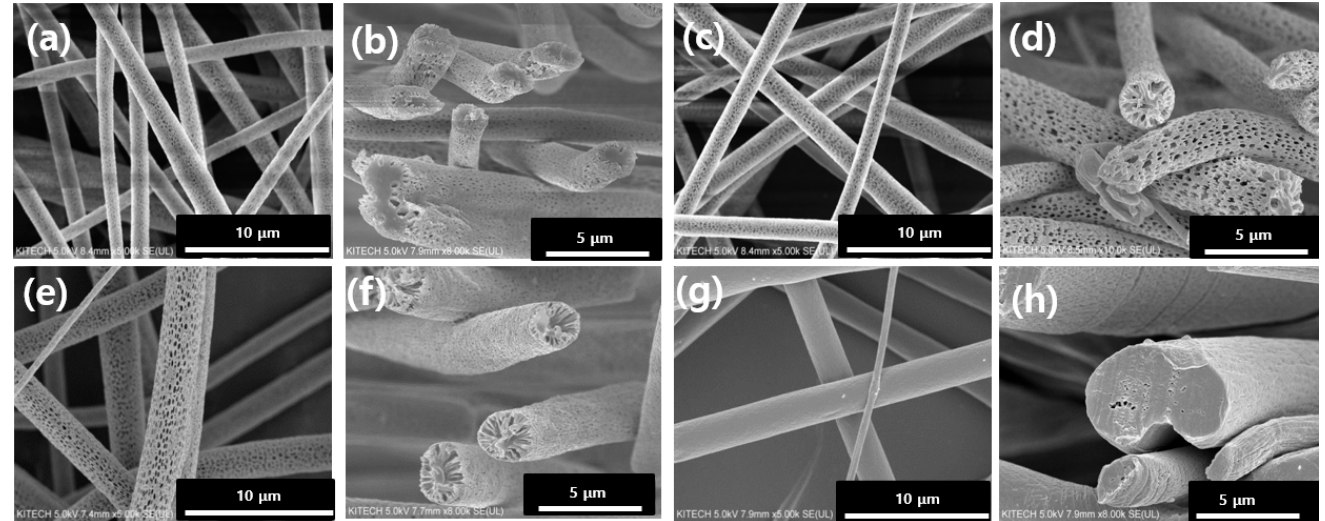
Figure 2. SEM images of porous and non-porous PLA microfibers in different polymer–solvent sys-